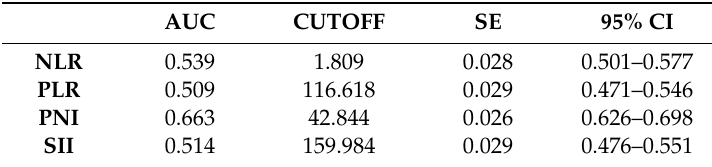
Table 2. Comparisons of the areas under the curve (AUC) values and the cuto ff values among the inflammatory markers.